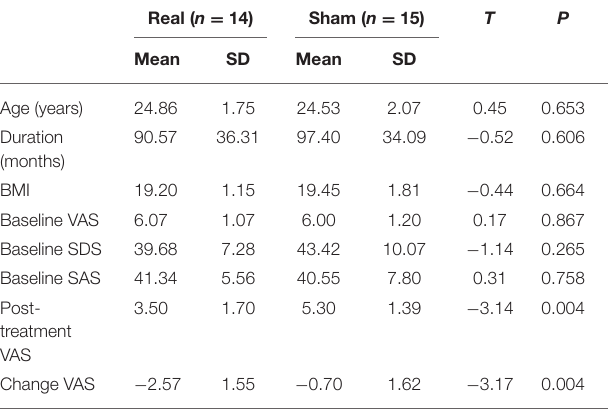
TABLE 1 | Demographics and clinical characteristics of each